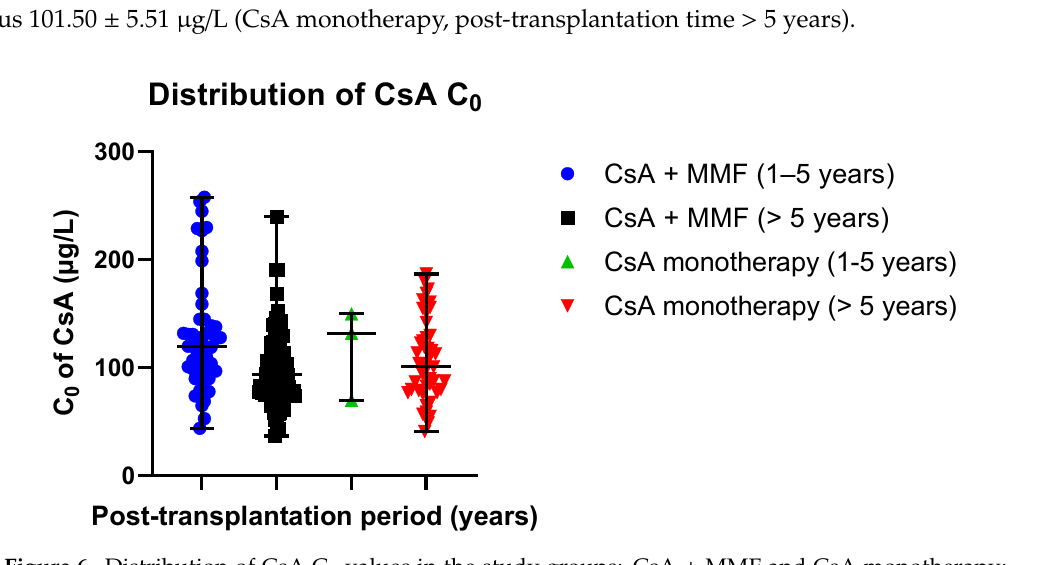
Figure 5. Distribution of the CsA AUC (0–12) exposure values in the study groups: CsA + MMF and CsA monotherapy; MMF—mycophenolate mofetil; CsA—cyclosporine. Scatter plots display the individual AUC (0–12) exposure values’ distribution from the median in CsA ‐ receiving study groups (median ± SE): 3.02 ± 0.13 mg/h/L (CsA + MMF, post ‐ transplantation time: 1–5 years) versus 3.56 ± 0.55 mg/h/L (CsA monotherapy, post ‐ transplantation time: 1–5 years); 2.84 ± 0.80 mg/h/L (CsA + MMF, post ‐ transplantation time > 5 years) versus 2.91 ± 0.10 mg/h/L (CsA monotherapy, post ‐ transplantation time > 5 years). Respectively, the mean values (mean ± SD) were as follows: 3.31 ±